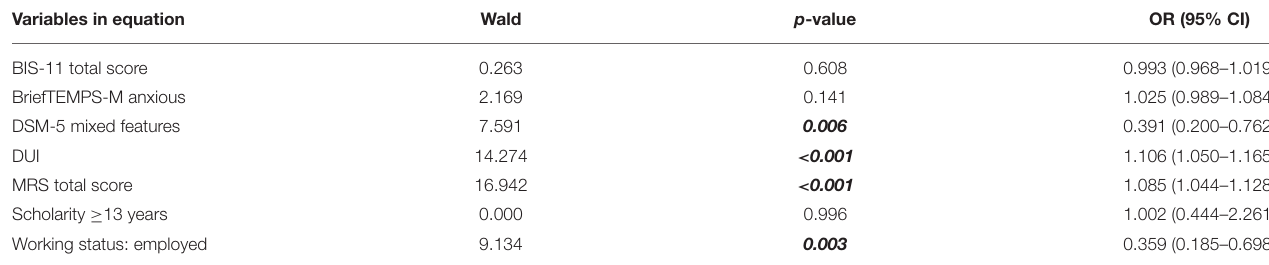
TABLE 2 | Logistic regression model evaluating socio-demographic, clinical, and psychopathological variables associated with female sex in our